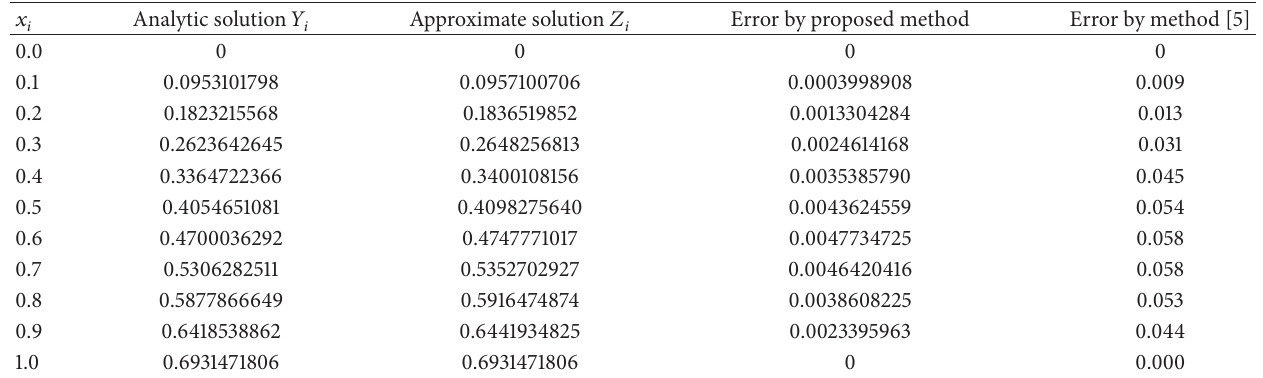
Table 1: Numerical results of Example 1: ℎ = 10 −1